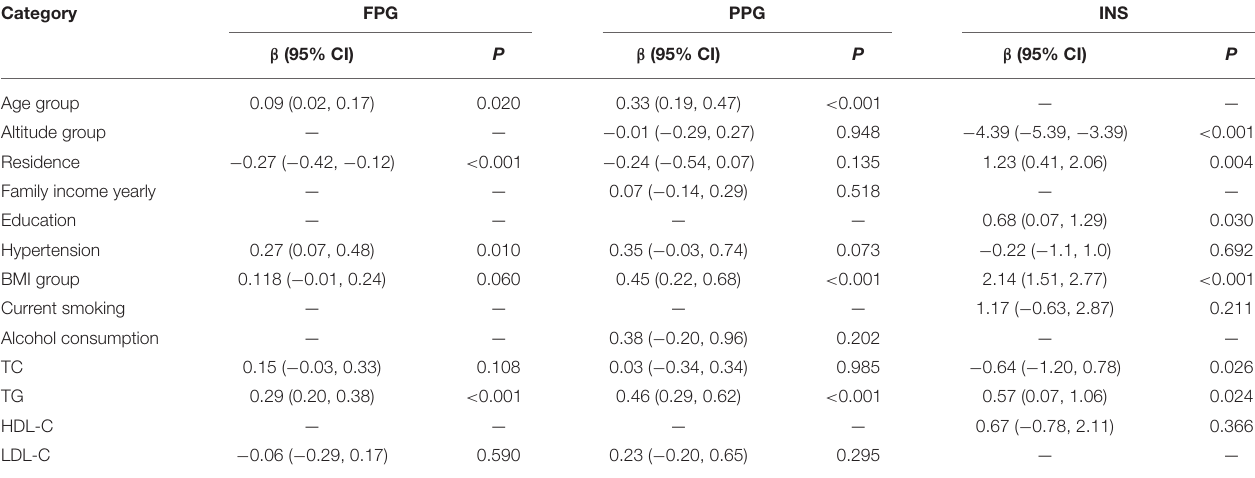
TABLE 4 | Determinants of FPG, PPG, and INS among Tibetans aged ≥ 18 years using multivariate regression analysis.